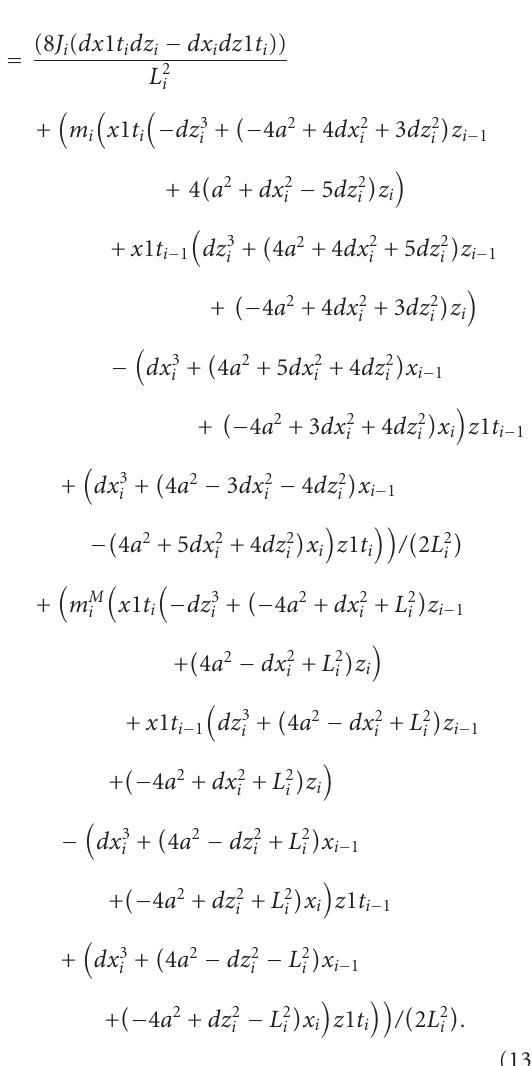
˙ (cid:4) , H g ,0 } ( i = β i